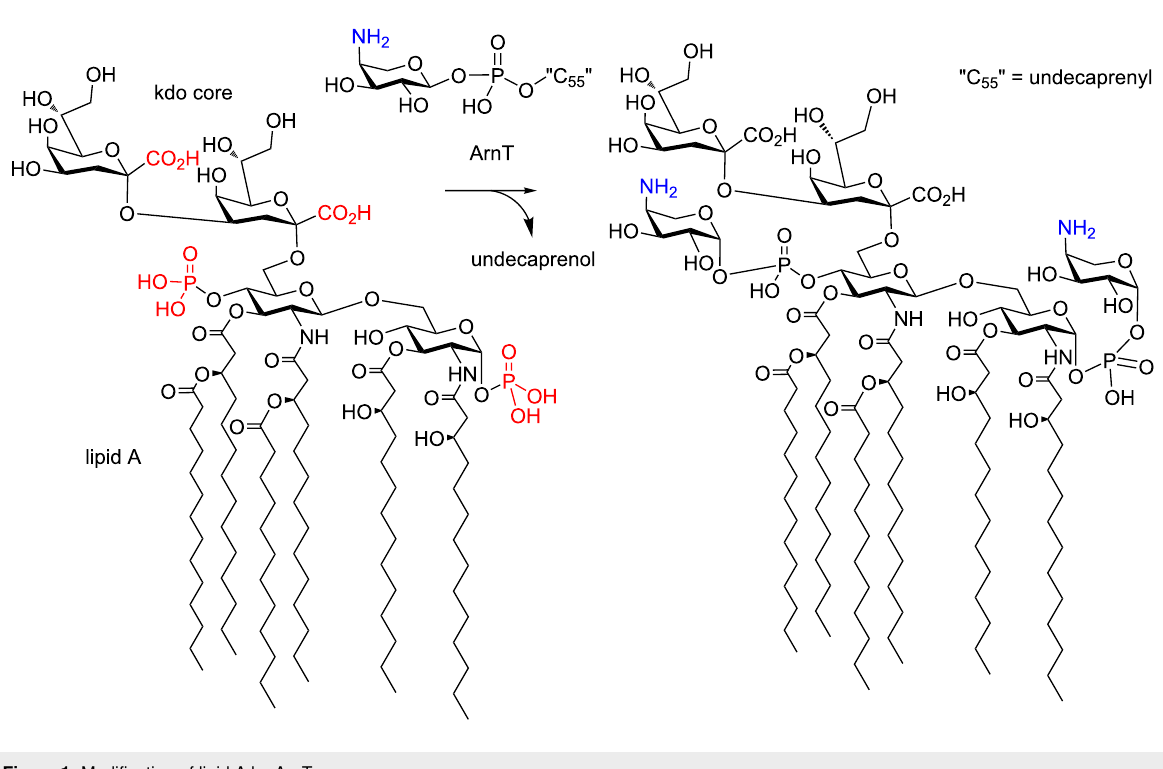
Figure 1: Modification of lipid A by